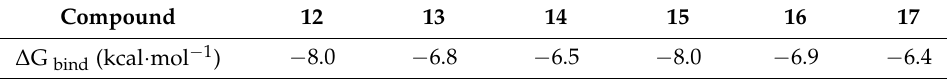
Table 3. Predicted ∆ G bind from the semi-flexible docking of molecules 19 – 24 with BSA. Compound